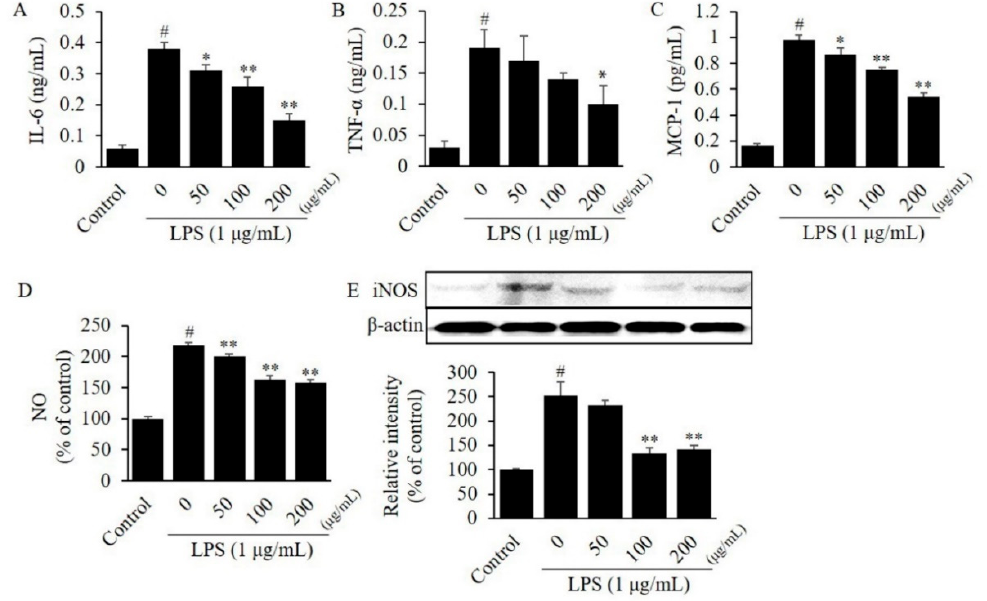
Figure 4. Effect of CTFV on the inflammatory response in 3T3-L1 cells. The levels of IL-6 ( A ), TNF- α ( B ), MCP-1 ( C ), NO ( D ), and iNOS ( E ) in 3T3-L1 cells were measured by ELISA, the Griess reagent, and western blot analysis. Measurement of these expression or levels in non-treated cells was used as the control group. Each value is the mean ± SD of triplicate measurements. # p < 0.01, compared with non-treated group. * p < 0.05 and ** p < 0.01, compared with only LPS-treated group. CTFV, C. tricuspidata fruits vinegar; IL, interleukin; TNF, tumour necrosis factor; MCP, monocyte chemoattractant protein; NO, nitric oxide; iNOS, inducible nitric oxide synthase; ELISA, enzyme-linked immunosorbent assay; LPS,